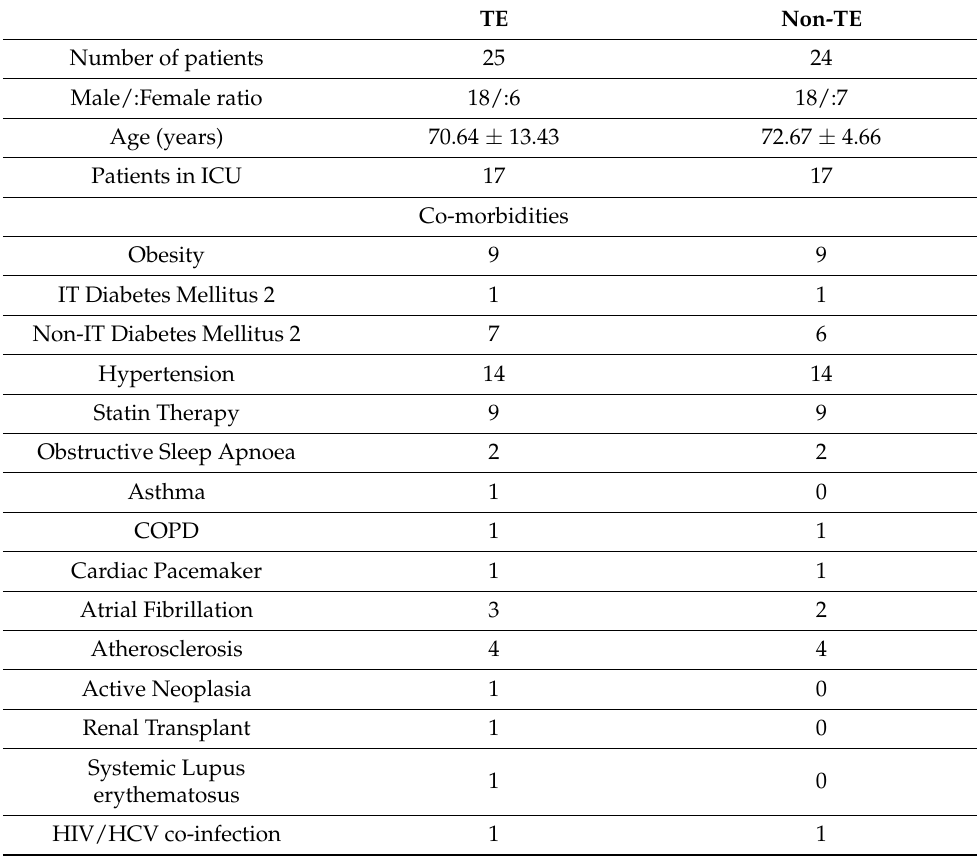
Table 1. Characteristics of patients with TE and the selected control group. TE: Thrombotic event; ICU: Intensive care unit; IT: Insulin Treated; COPD: Chronic obstructive pulmonary disease; HIV: Human immunodeficiency virus; HCV: Hepatitis C